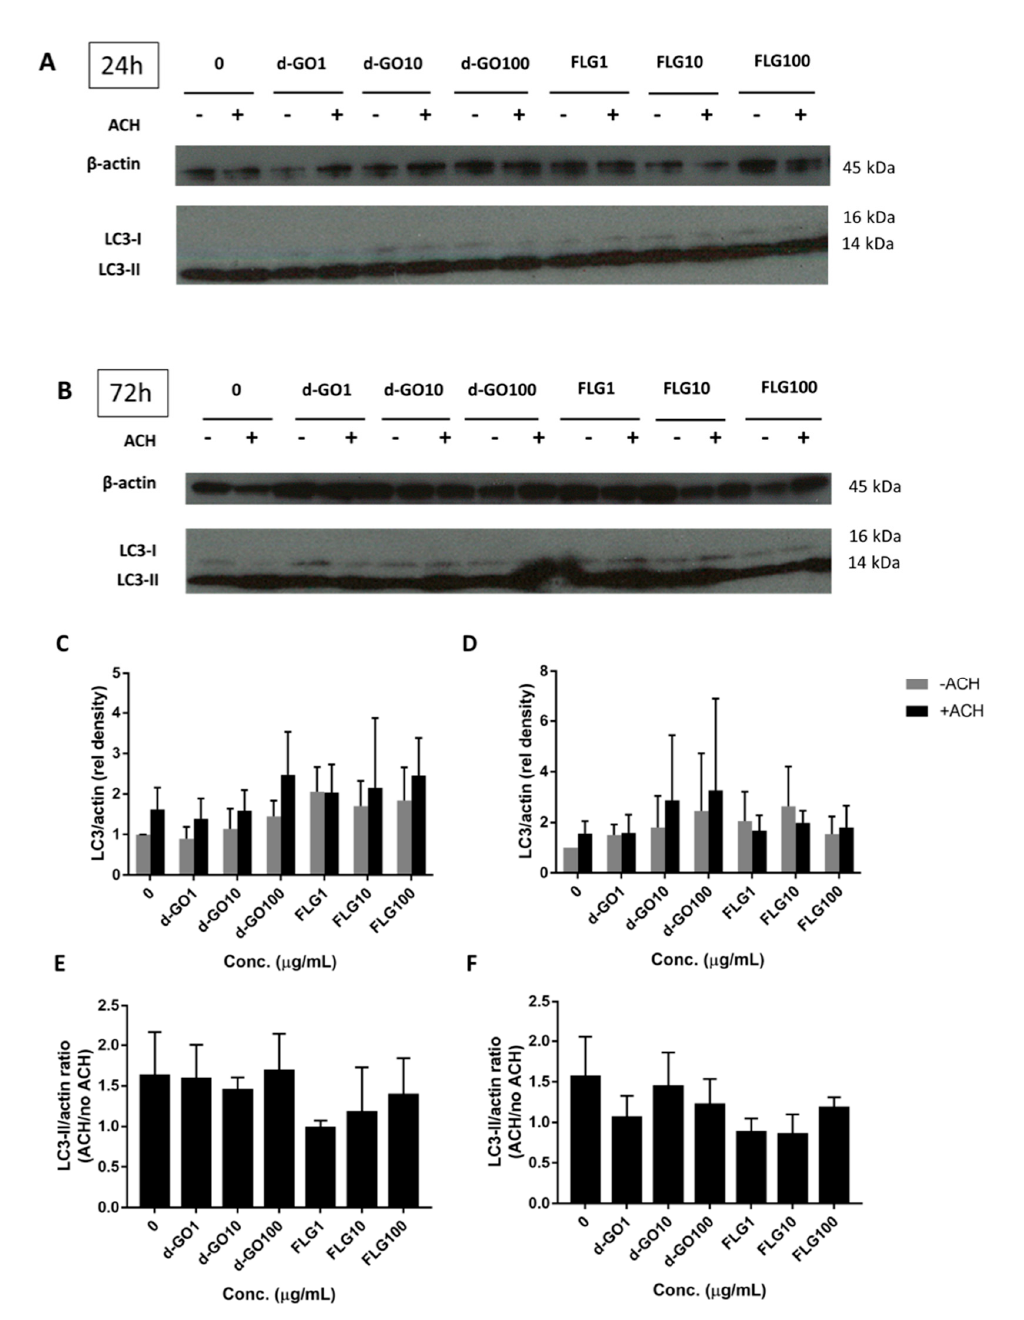
Figure 4. Autophagy e ff ects in HaCaT cells exposed to GBMs. HaCaT cells were exposed to GBMs (1, 10 and 100 µ g / mL FLG or d-GO) for 24 or 72 h (continuous exposure) before the evaluation of autophagic flux. ( A , C , E ) 24 h exposure and ( B , D , F ) 72 h exposure. Autophagic flux ( E , F ) is the ratio of LC3-II / actin ( C , D ) treated with ammonium chloride (ACH) over LC3-II / actin not treated with ACH. Figure 4E (relative density graph of Figure 4A) was derived from Figure 4C, while Figure 4F